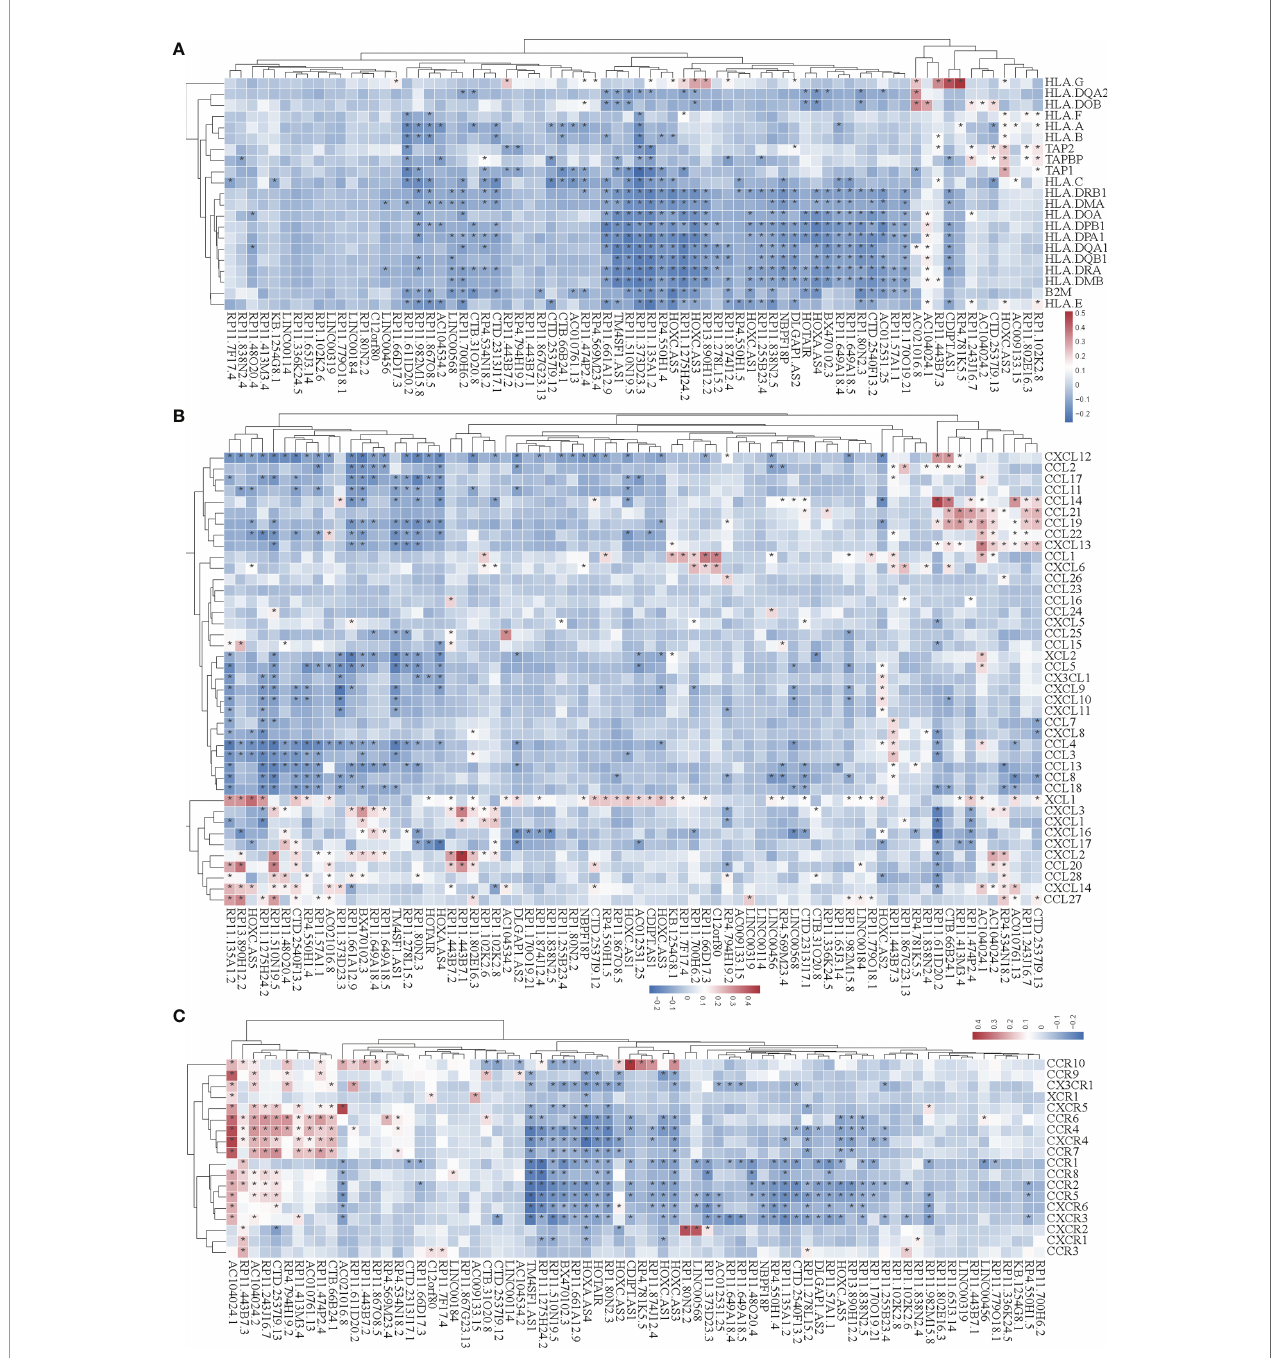
FIGURE 5 | Correlation analysis of the expression of super-enhancer-associated lncRNA and chemokines in STAD cells. (A) Results of cluster analysis of the expression correlation between 74 SE-associated lncRNAs and MHC molecules. (B) Cluster analysis results of the expression correlation between 74 SE-associated lncRNA and chemokines. (C) Results of the cluster analysis of the expression correlation between 74 SE-associated lncRNAs and chemokine receptors. Red signi fi es a positive correlation, while blue indicates negative correlation. The asterisk (*) is used to signify signi fi cant correlation ( p < 0.05). The list of MHC